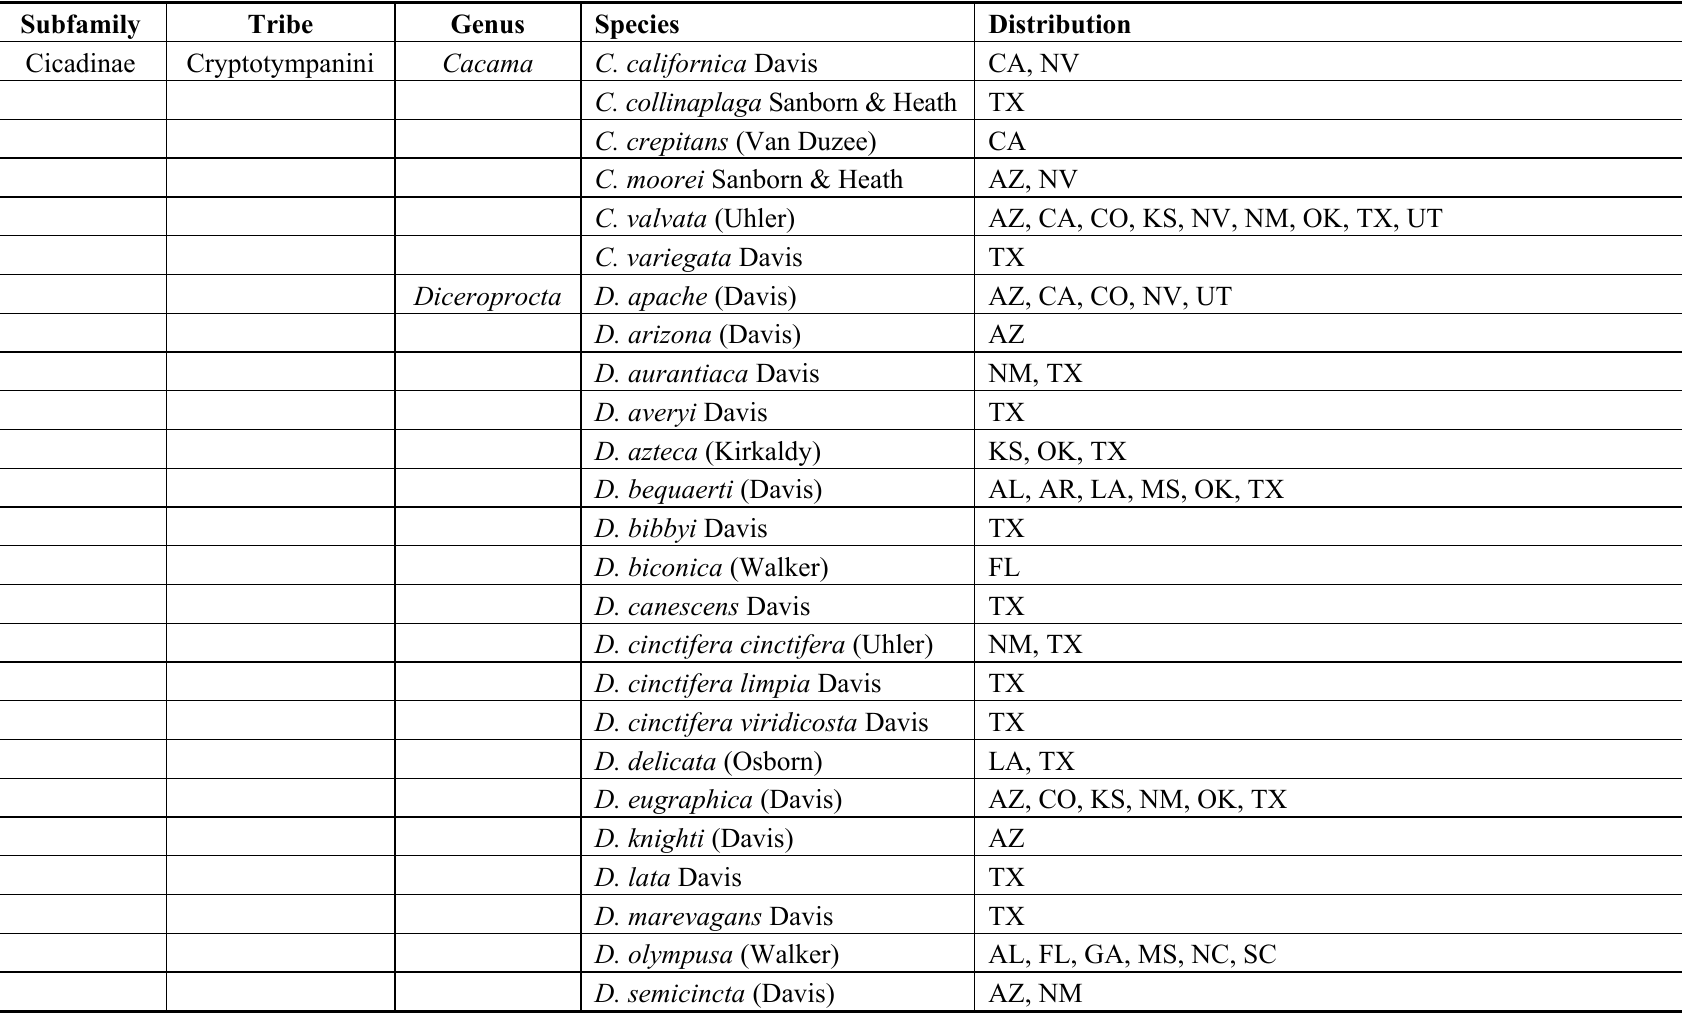
Table 1. Diversity and distribution of the cicadas of North America, north of Mexico. All species are members of the family Cicadidae. State and provincial abbreviations follow the postal code system for the USA and